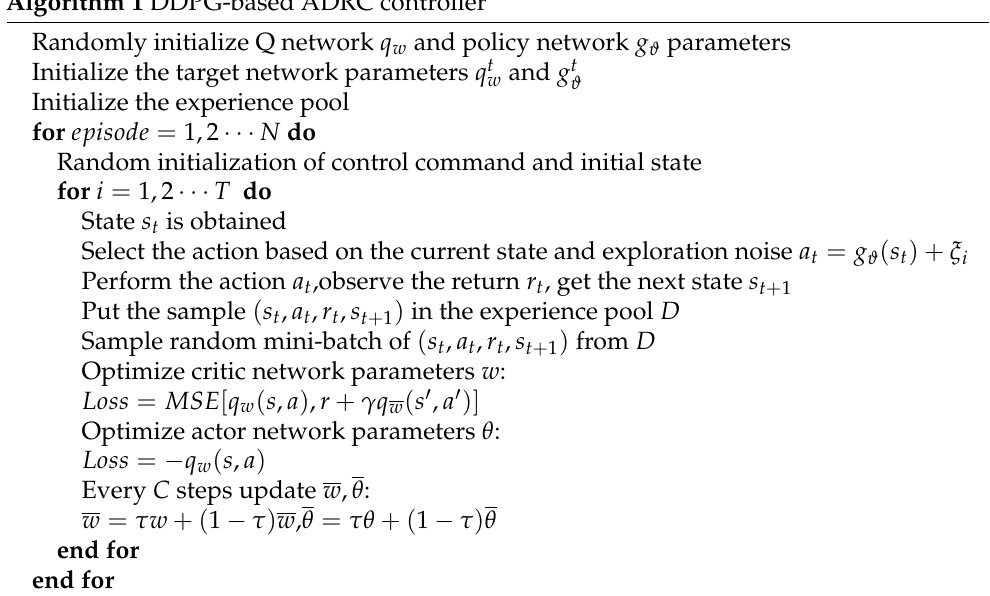
Algorithm 1 DDPG-based ADRC controller Randomly initialize Q network q w and policy network g ϑ